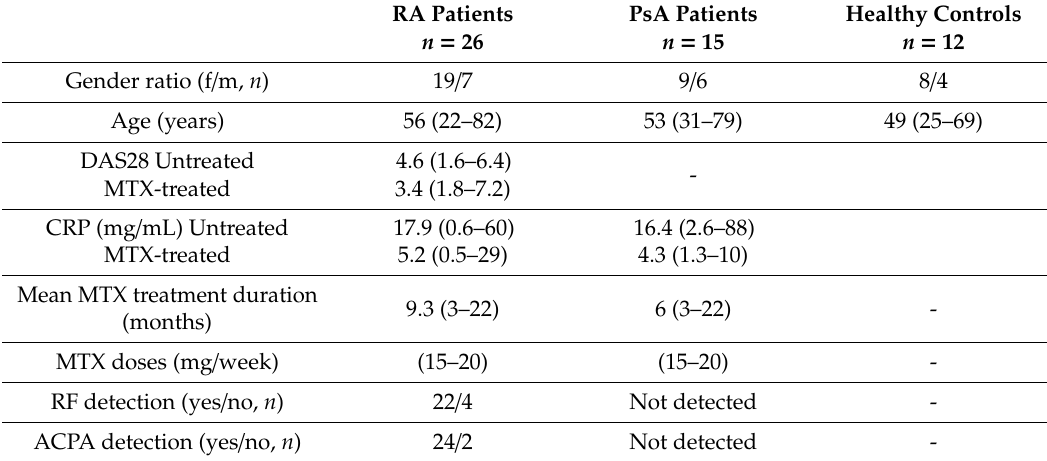
Table 1. Characteristics of RA and PsA patients enrolled in the